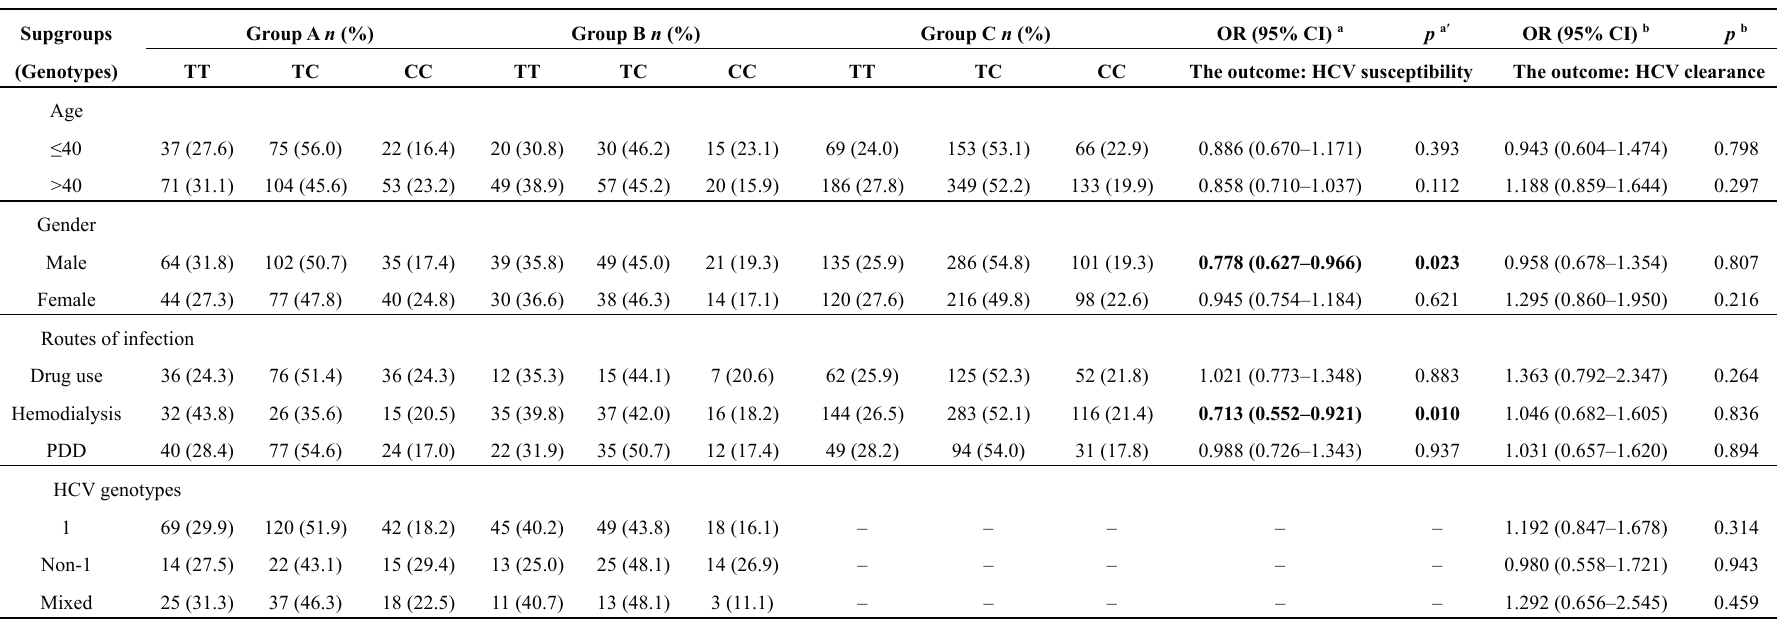
Table 3. Stratified analysis of HLA rs2856718 among persistent infection, spontaneous clearance and control